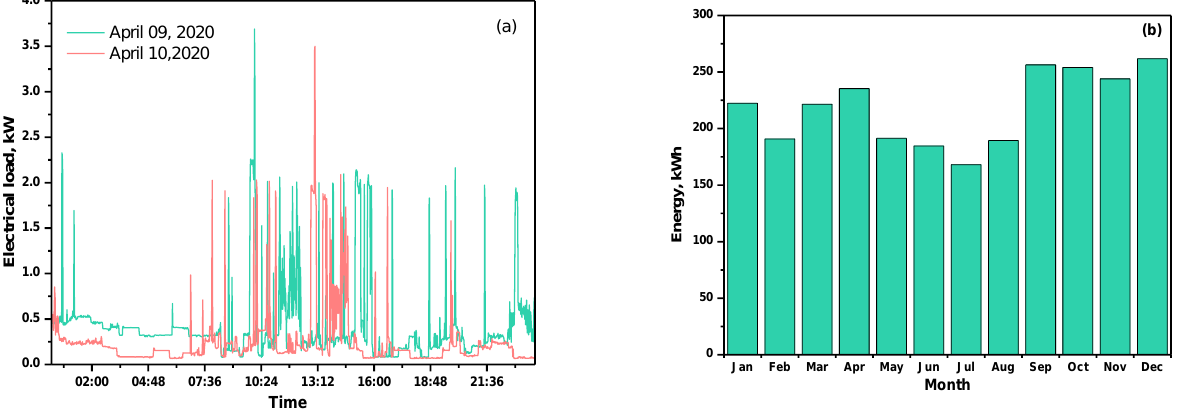
Figure 1. The electrical load for 9 April and 10 April 2020 ( a ) and the monthly average energy consumption ( b ). Solar radiation: Total solar radiation was measured in the horizontal plane from 1 campus in Krakow, Poland, at a 1 min temporal resolution. The daily average irradiance on the horizontal plane was recorded at 2.9 kWh/m 2 /day, where the highest monthly average irradiance was 6.29 kWh/m 2 /day in July and the lowest monthly average irradiance was 0.59 kWh/m 2 /day in December. Figure 2a,b shows the daily (for 9 and 10 April 2020) and monthly average irradiance, respectively.